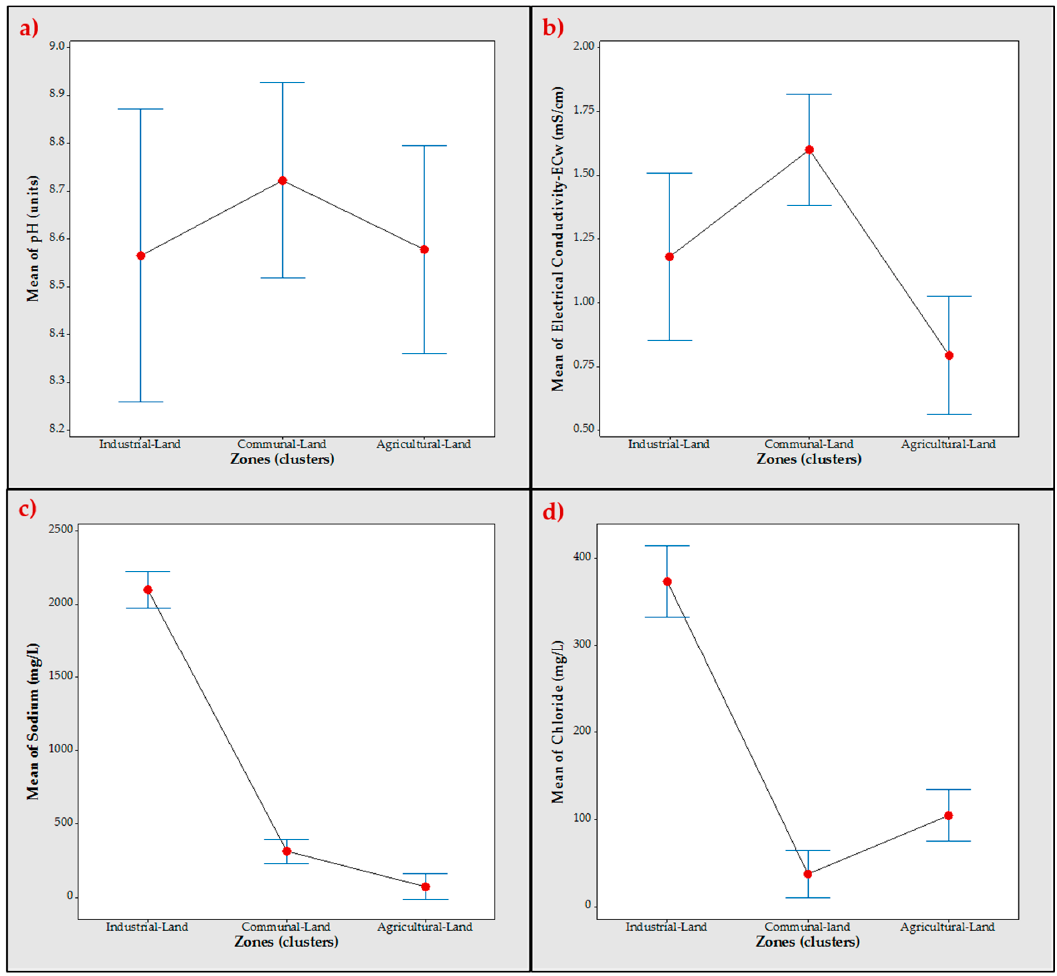
Figure 2 . Levels of the parameters ( a ) pH, ( b ) ECw, ( c ) Na + and ( d ) Cl − in water samples obtained in Bustillos Lagoon in Chihuahua, Mexico.